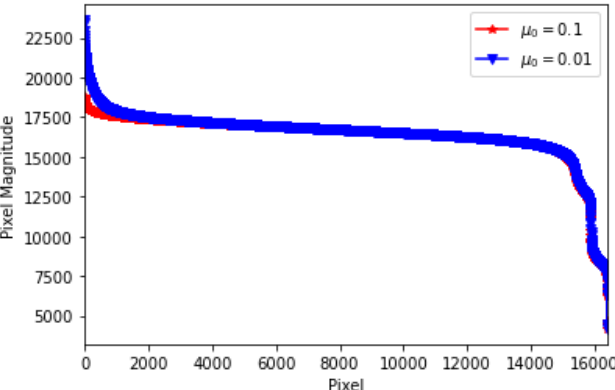
Figure 6. Rate of decay of coefficients for µ 0 = 0.1 and µ 0 = 0.01.